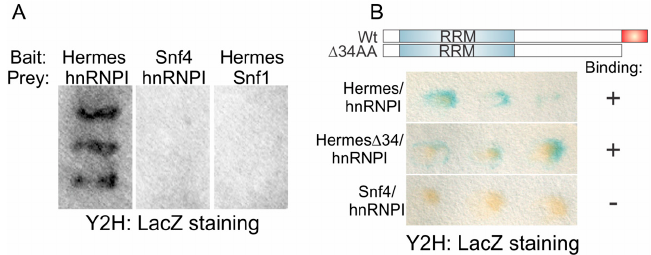
Figure 4. Hermes/Rbpms interacts with another Nanos1 binding protein: To identify proteins that might interact with Hermes/Rbpms during early oogenesis, a Xenopus cDNA library (Clontech) was screened using a yeast two-hybrid (Y2H) system. ( A ) Full length Hermes/Rbpms fused with the DNA binding domain (BD) of the transcription factor Gal4 served as bait. Candidate interacting proteins were fused to the Gal4-activation domain (AD) and served as prey. The reporter gene B-galactosidase, driven by the Gal4 binding site, was positively transcribed as the result of Hermes/Rbpms and hnRNP I (heterogeneous nuclear ribonucleoprotein I) interaction. Two proteins involved in yeast glucose metabolism, Sfn4 and Sfn1, were used as controls to discard false positive results. Snf4/Gal4-BD was used as a bait and Snf1/Gal4-AD as a prey to check false interactions with hnRNP I and Hermes/Rbpms protein respectively; ( B ) The C-terminal 34 amino acids (in red) required for Hermes/Rbpms to dimerize and bind nanos RNA are not required to interact with hnRNP I. Hermes/Rbpms protein lacking the terminal 34 AA was used as bait and hnRNP I as prey. Induction of B-galactosidase indicated a positive interaction between bait and